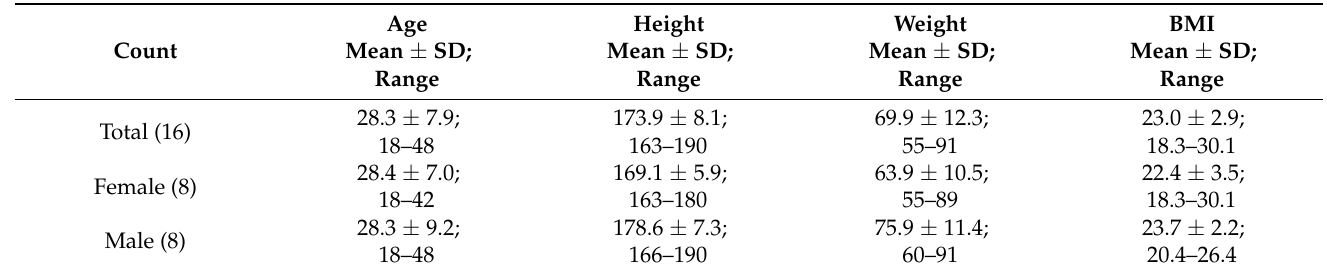
Table 1. Subject anthropometric parameters. Age (years), height (cm), weight (kg) and body mass index (BMI) (kg/m2) mean values with standard deviations